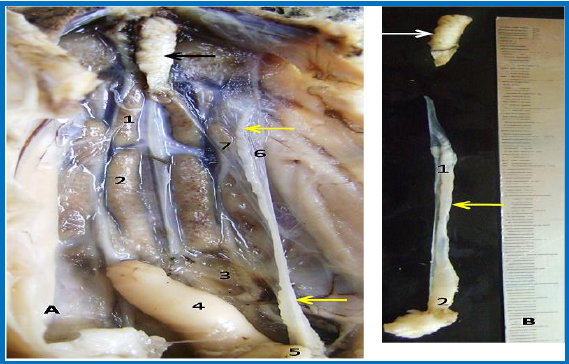
Figure, 2: Gross appearance at 8 weeks duckling body (Mallard duck) shows: A. The cranial division of right kidney (1), middle division of right kidney (2), caudal division of left kidney (3), supra cloacal gland (4), cloaca (5), ventral oviductal ligament (6), dorsal oviductal ligament (7) ovary (black arrow) oviduct, (yellow arrow). B. Theovary (White arrow) and the left oviduct (yellow arrow) which consisted of cranial end (1), caudal end (2).